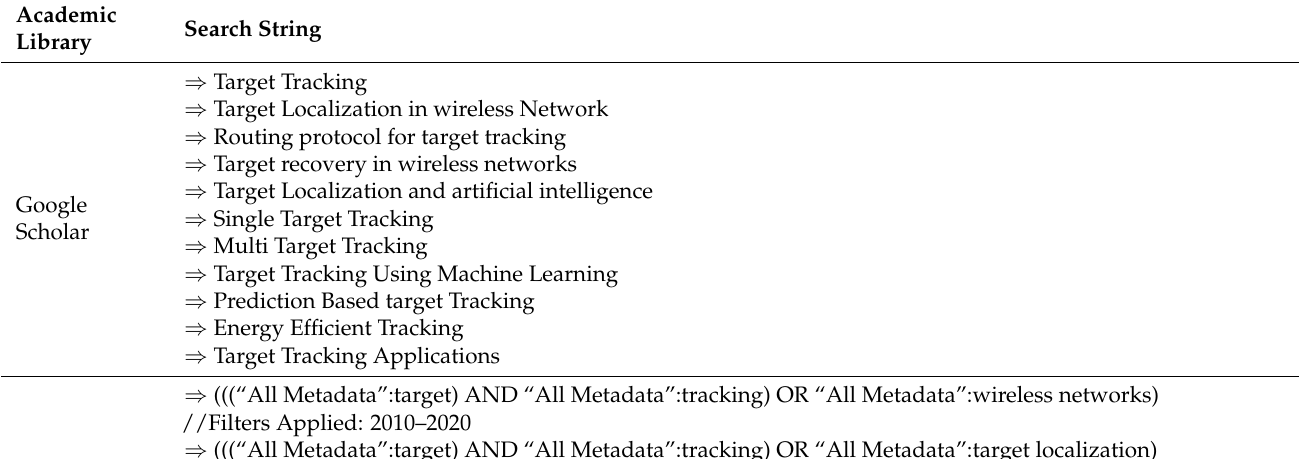
Table 2. Strings used in search